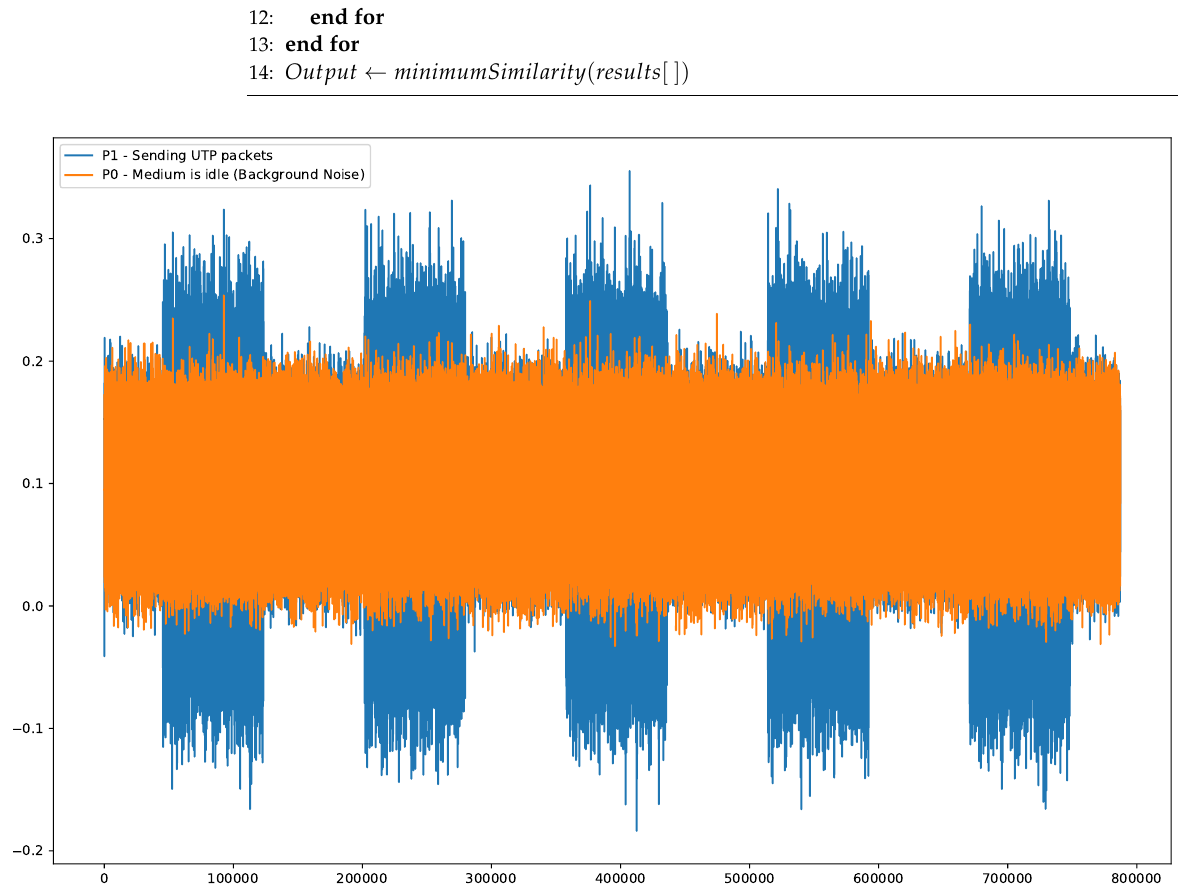
Figure 2. Comparison of waveform of traffic patterns P0 & P1 at 220